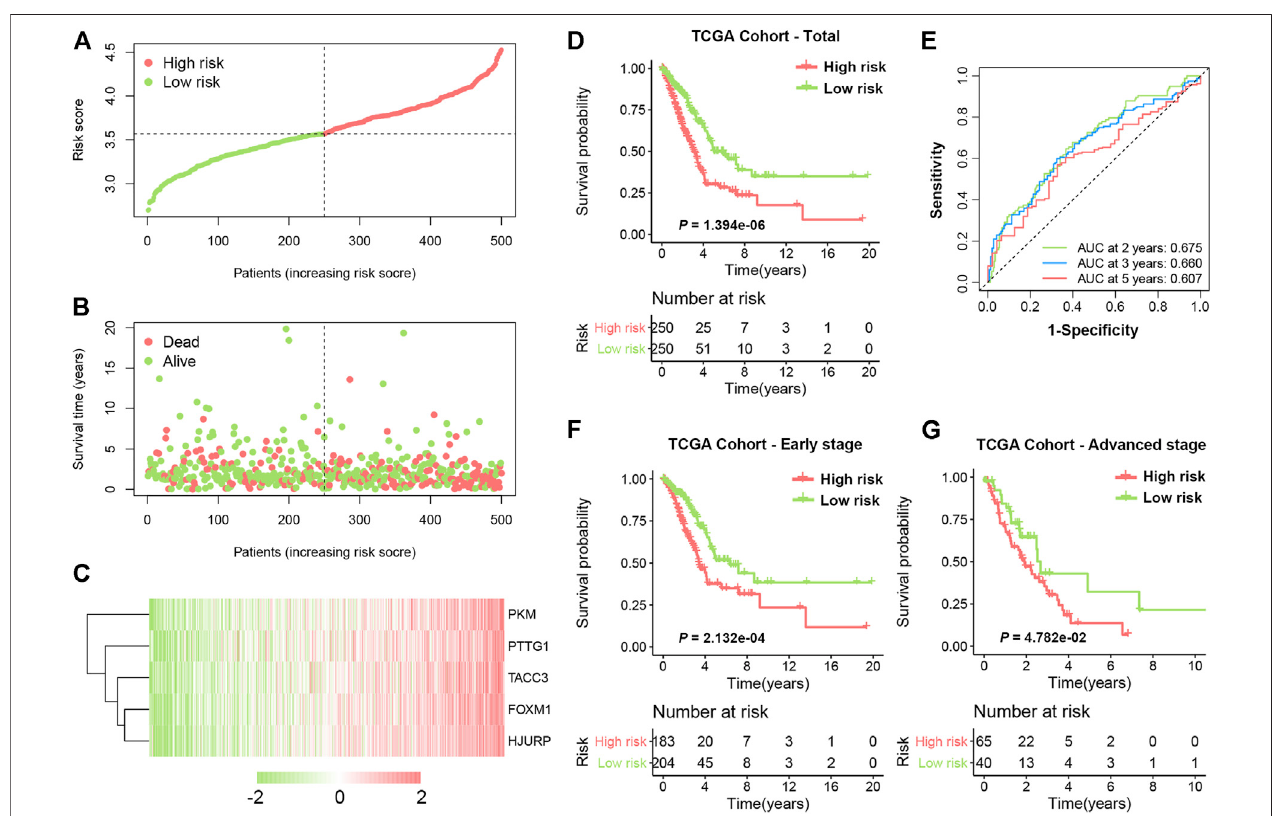
FIGURE3 | DevelopmentofSRS inTCGA cohort. (A) .The riskscore distribution ofLUAD patientsin thetraining cohort. (B) .Survivalstatus scatter plots for LUAD patients in the training cohort. (C) . Heatmap of the expression pro fi les of fi ve signature genes in the high- and low-risk groups. (D) . Kaplan-Meier curves of OS in total LUAD patients of TCGA cohort based on risk score. (E) . Time-dependent ROC curve analysis of the prognostic model (2, 3, and 5 years). (F) and (G) . Kaplan-Meier curves of OS in patients with early-stage and advanced-stage LUAD based on risk score.